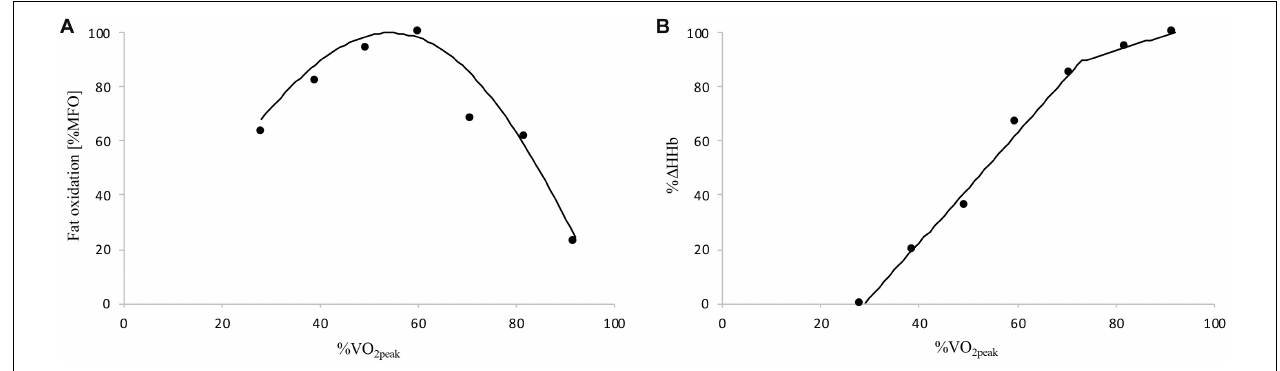
FIGURE 4 | Example of the whole-body fat oxidation (A) and muscle deoxygenation (B) kinetics of a cyclist participant determined during the submaximal incremental test. (cid:49) [HHb], variation in deoxygenated hemo- and myoglobin concentration; MFO, maximal fat oxidation; ˙ VO 2 peak , peak oxygen uptake.